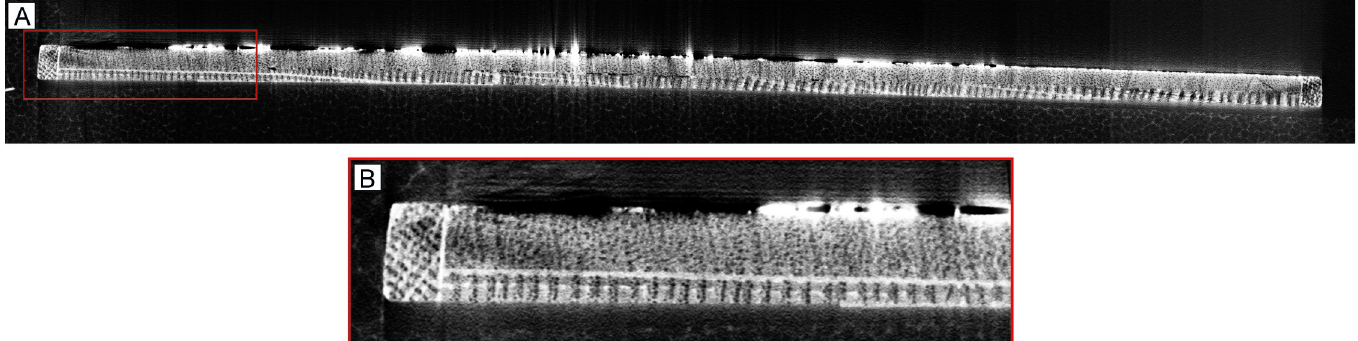
Fig 4. Reconstructed CT images. (A) Reconstructed CT image of the full cross-section of the panel, providing an overall impression of the configuration of the panel and the transverse section of the oak back board, which has been processed radially from the parental tree; (B) reconstructed CT image of the Tile 2. Tile 2 corresponds to the left edge of the panel in (A), and the reconstructed image (with 37.3 micron resolution) shows: the oak strip on the left; the paint layer on the upper part, with white areas caused by highly absorbing metal-containing pigments in the paint; the original wooden painting support, which appears to be of a diffuse-porous species; and a second (oak) board glued on the back of the original board. The oak board was initially the target of this investigation as it was assumed to be the original support. Tree rings in the oak board are evident in this image (growth direction towards the left in both